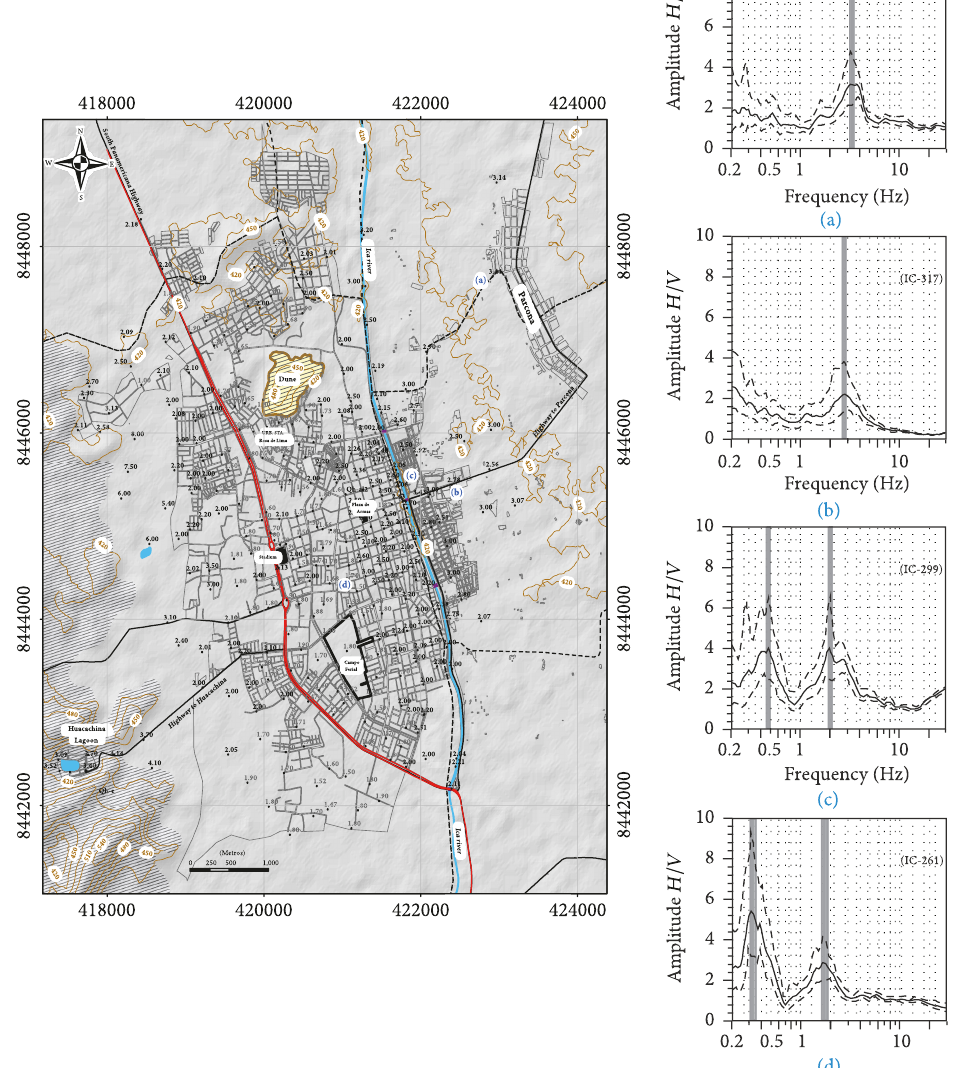
Figure 2: Spatial distribution of the frequency 𝐹1 ( 𝐹 > 1.0 Hz) and examples of spectral ratios obtained in several